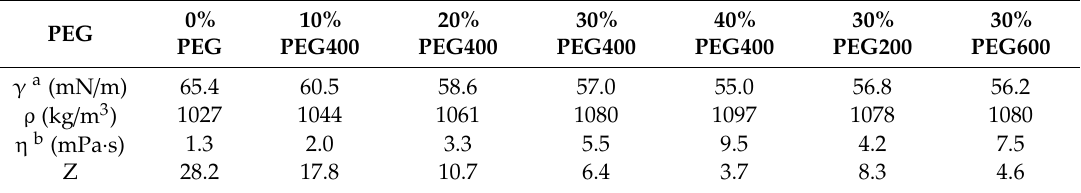
Table 2. The physical properties and Z values of PEG–dye aqueous solutions.